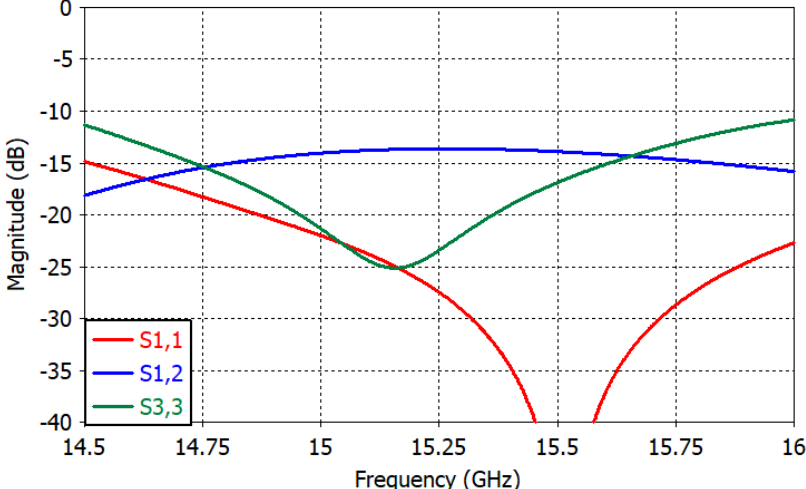
Figure 6. Reflection and coupling coefficients of the designed feed.